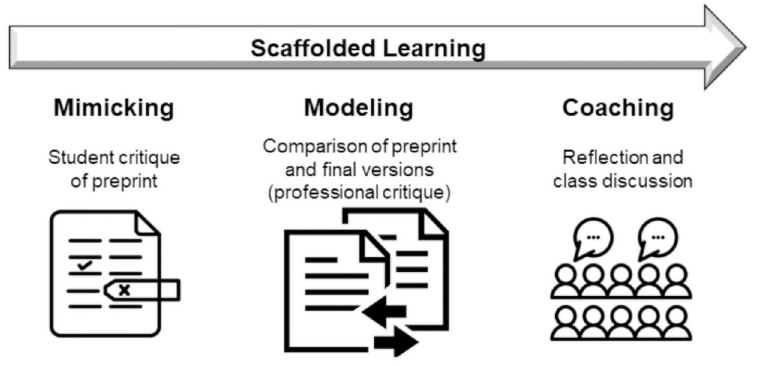
Fig 4. Scaffolded learning using preprint